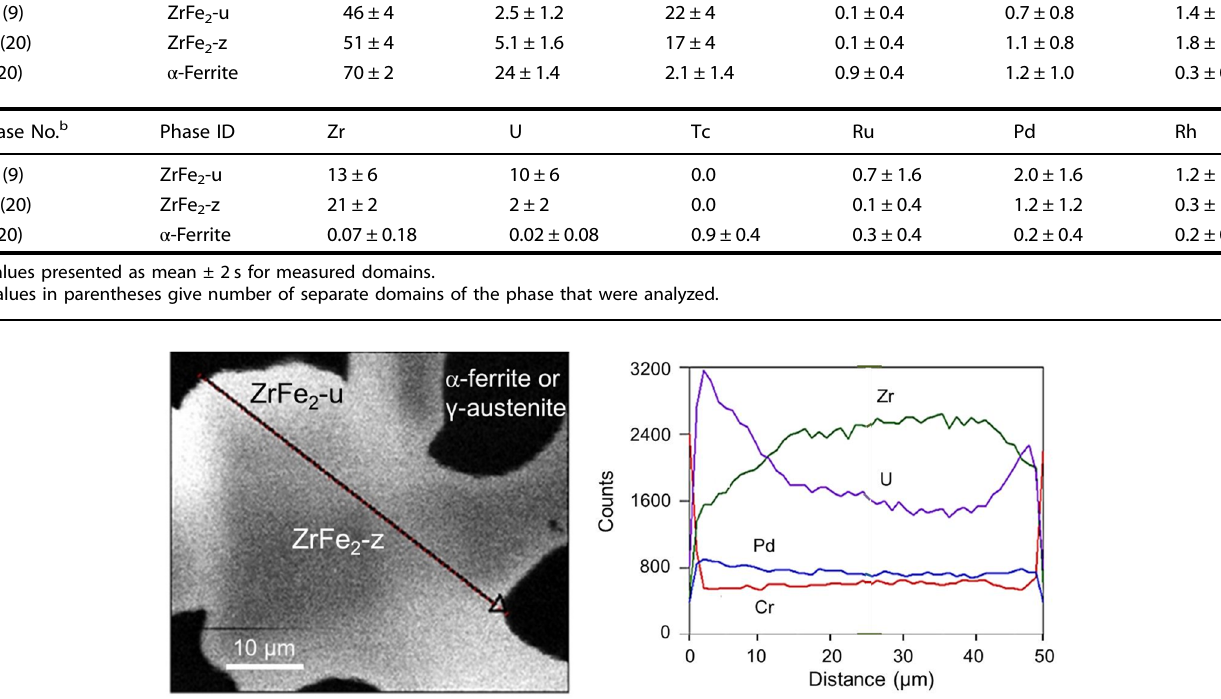
Fig. 2 EDS line pro fi le measures the relative amounts of Zr and U in the FeZr 2 phase in the multiphase alloy nuclear waste form. Showing results for RAW-2. The scale bar on the left image 10 µm.